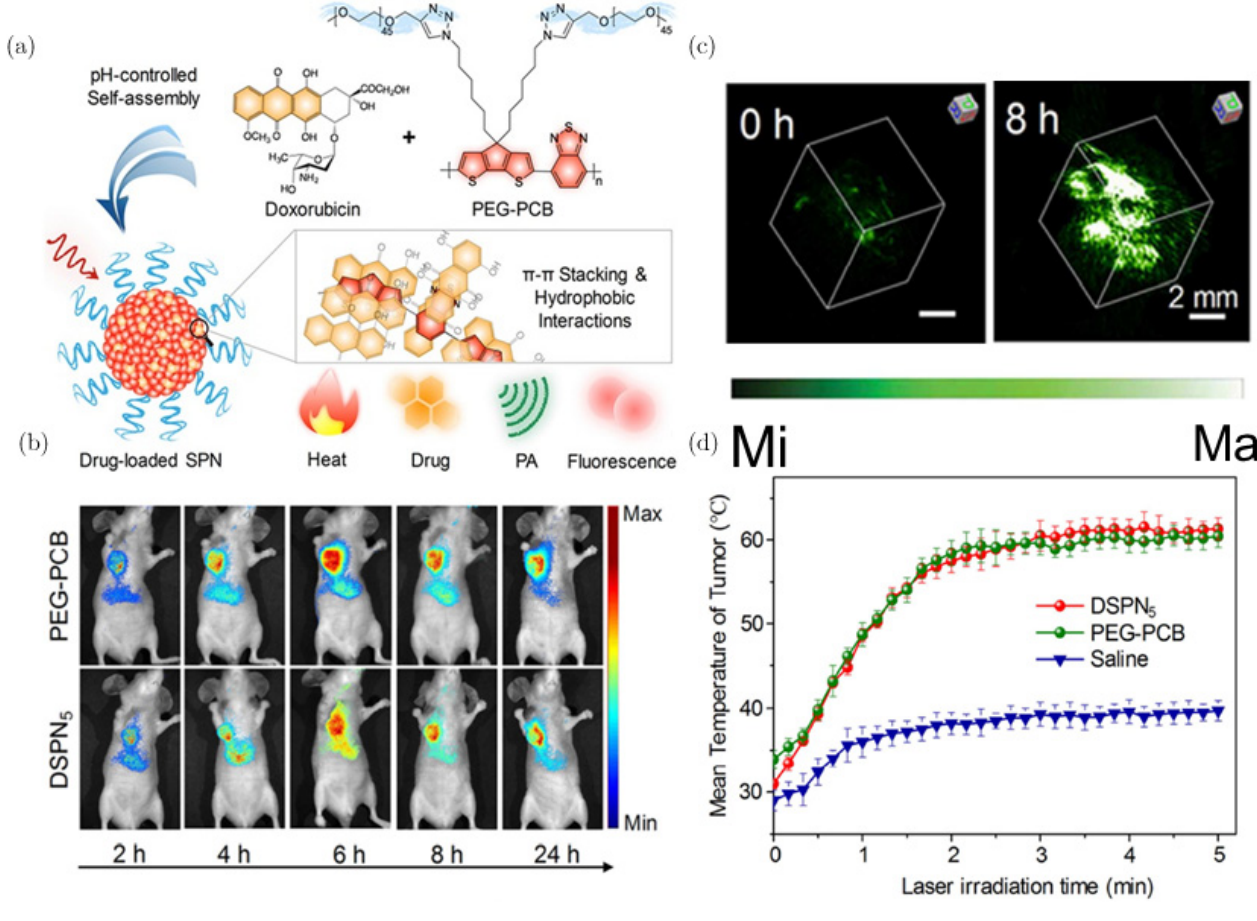
Fig. 6. PAI and FLI of tumor on living mice after the injection of PEG-PCB CPNs and tumor temperature evolution after injection PEG-PCB CPNs at laser